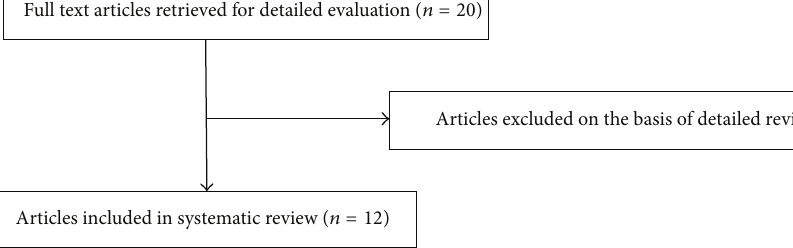
Figure 1: Flow diagram of literature search and selection of